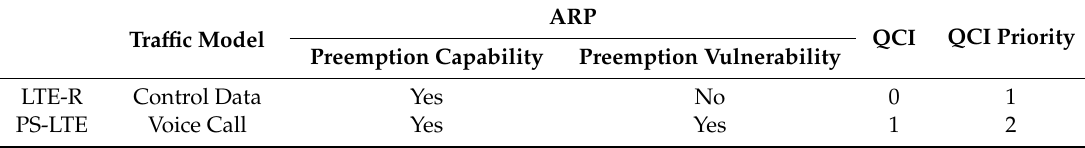
Table 2. QoS class identifier (QCI) priority under the tra ffi c model.